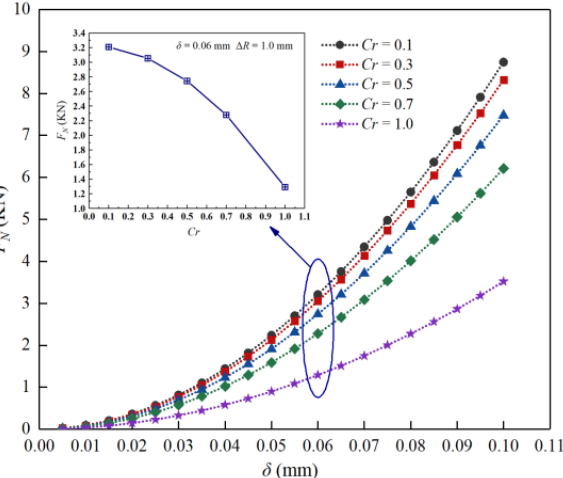
Figure 3. The influence of recovery coefficient C r and elastic deformation δ on the normal contact force F N .